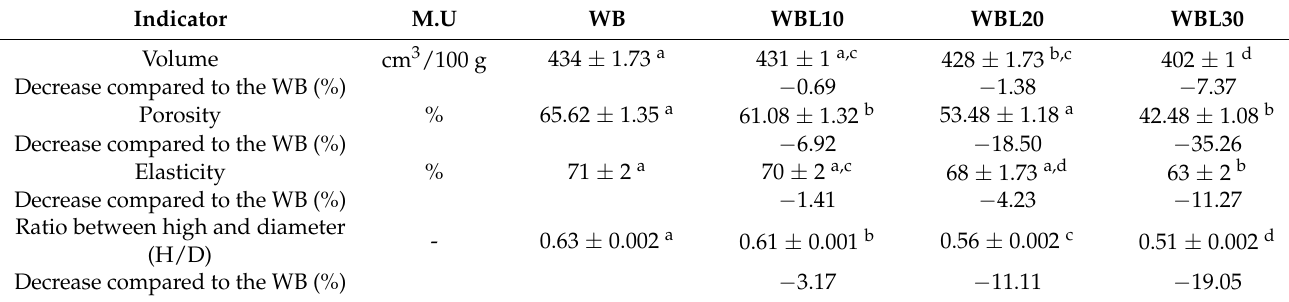
Table 8. Bread quality indicators for control wheat bread (WB); WBL10 (10% lupin flour and 90% wheat flour); WBL20 (20% lupin flour and 80% wheat flour); and WBL30 (30% lupin flour and 70% wheat